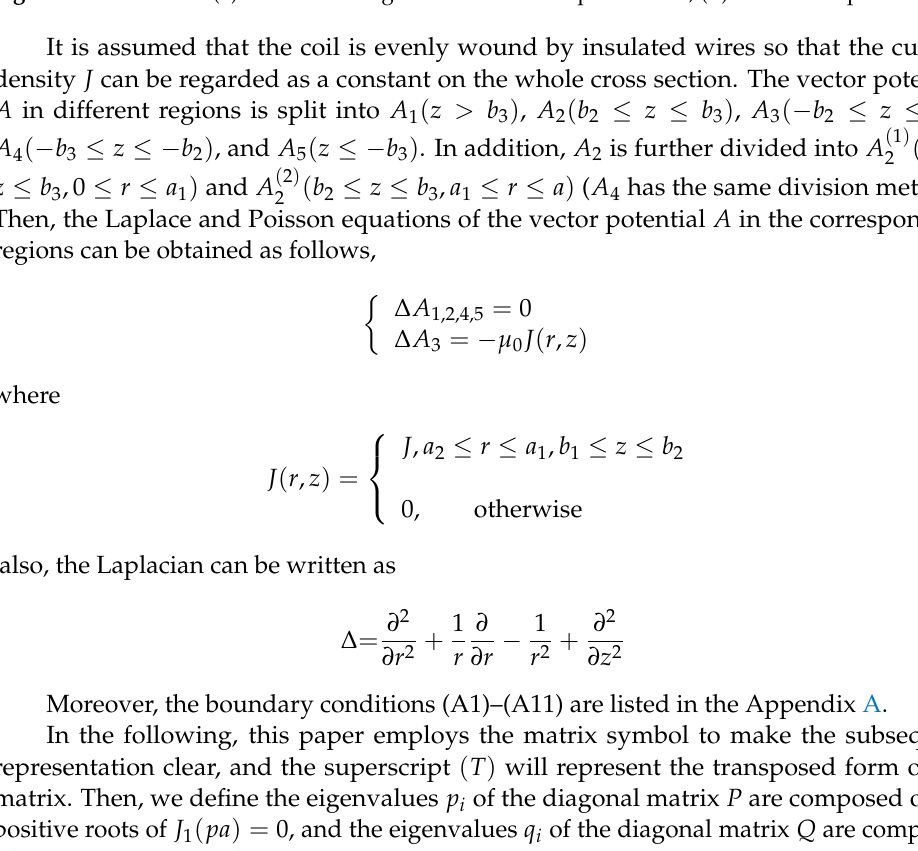
Figure 3. Planar core: ( a ) Schematic diagram and structure parameters; ( b ) Transverse